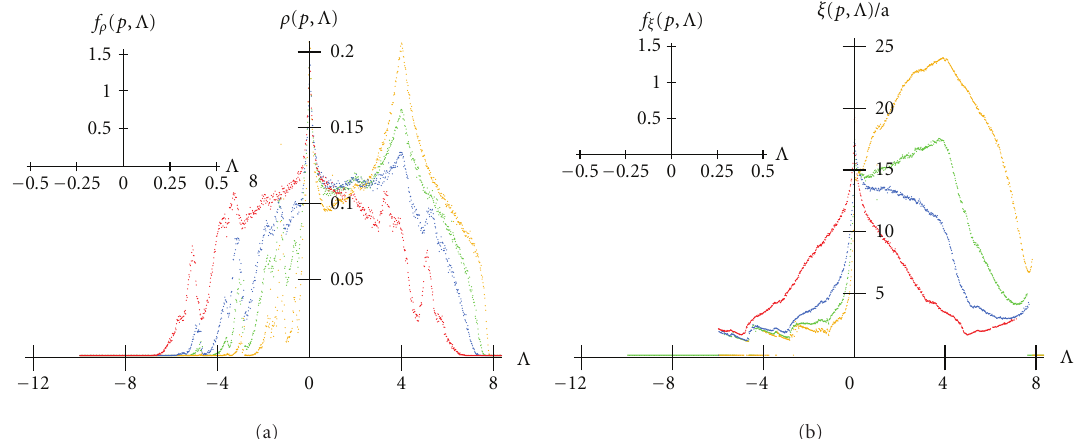
Figure 4: The surface plasmons density of states (DOS) (a) and localization length (b) are calculated for an ensemble of 100 metal-dielectric films each with size 1 μm . Four di ff erent metal filling fractions are investigated: p = 0 . 1 (yellow color), p = 0 . 2 (green color), p = 0 . 3 (blue color), and p = 0 . 5 (red color). The singularity at the band center and its dependence on the metal concentration is closely inspected in the insets [24, Figure